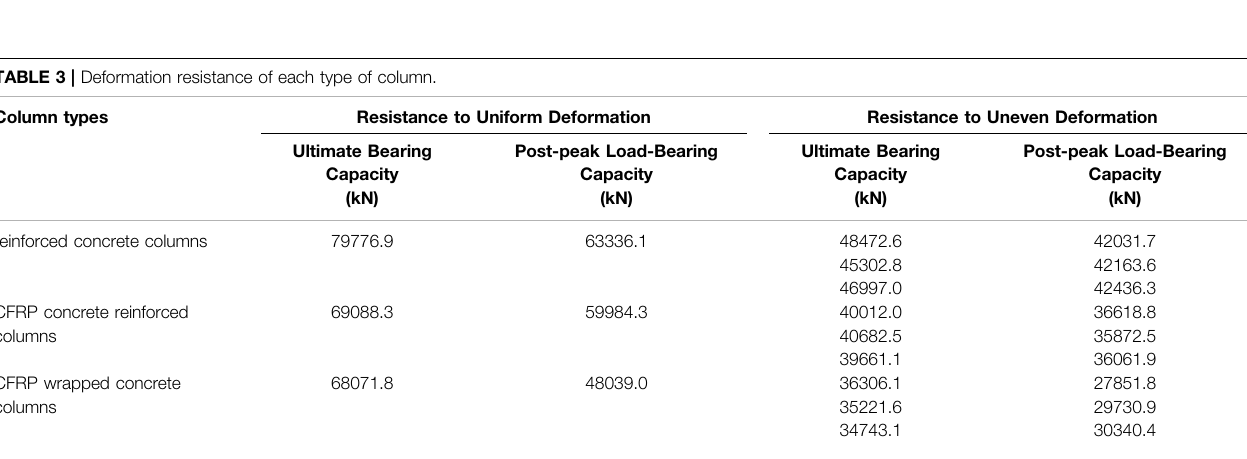
TABLE 3 | Deformation resistance of each type of